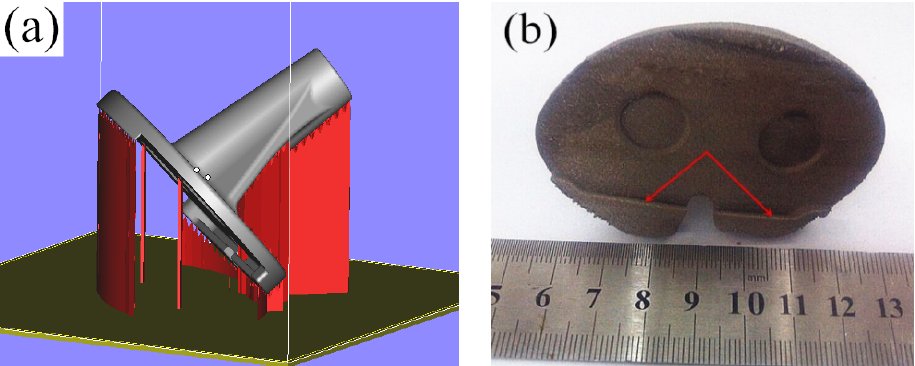
Figure 8. The addition way of the tibial prosthesis support and the effect of SLM molding: ( a ) Flip- ping of the fixed part of the tibial joint; ( b ) Post forming effect of SLM.